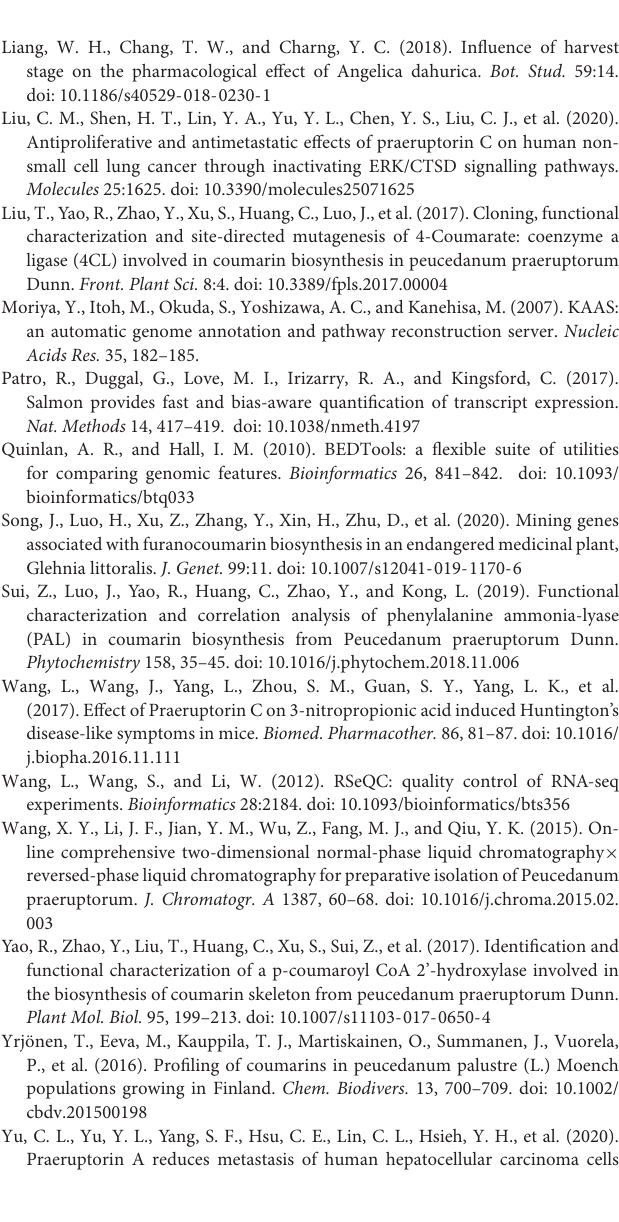
Supplementary Table 4 | The SSR markers of unigenes. Supplementary Table 5 | The significantly differential expressed genes between group A and B. Supplementary Table 6 | The significantly differential expressed genes between group A and C. Supplementary Table 7 | The significantly differential expressed genes between group C and D. Supplementary Table 8 | The significantly differential expressed genes between group E and F. Supplementary Table 9 | The functional GO enrichment of seven modules obtained by co-expression analysis. Supplementary Table 10 | The KEGG enrichment of seven modules obtained by co-expression